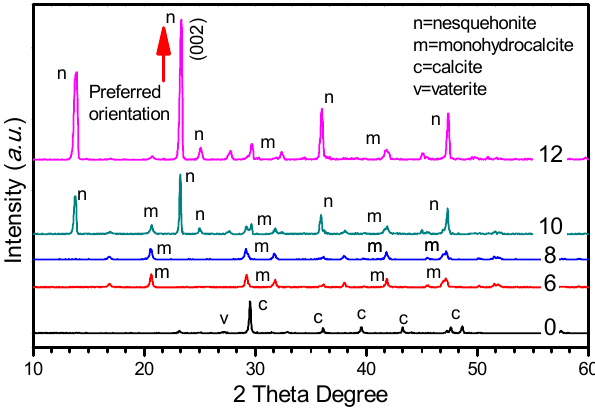
Figure 5. X-ray di ff raction analyses of the biominerals cultured for 12 days at di ff erent Mg / Ca Figure 5. X ‐ ray diffraction analyses of the biominerals cultured for 12 days at different Mg/Ca molar molar ratios.